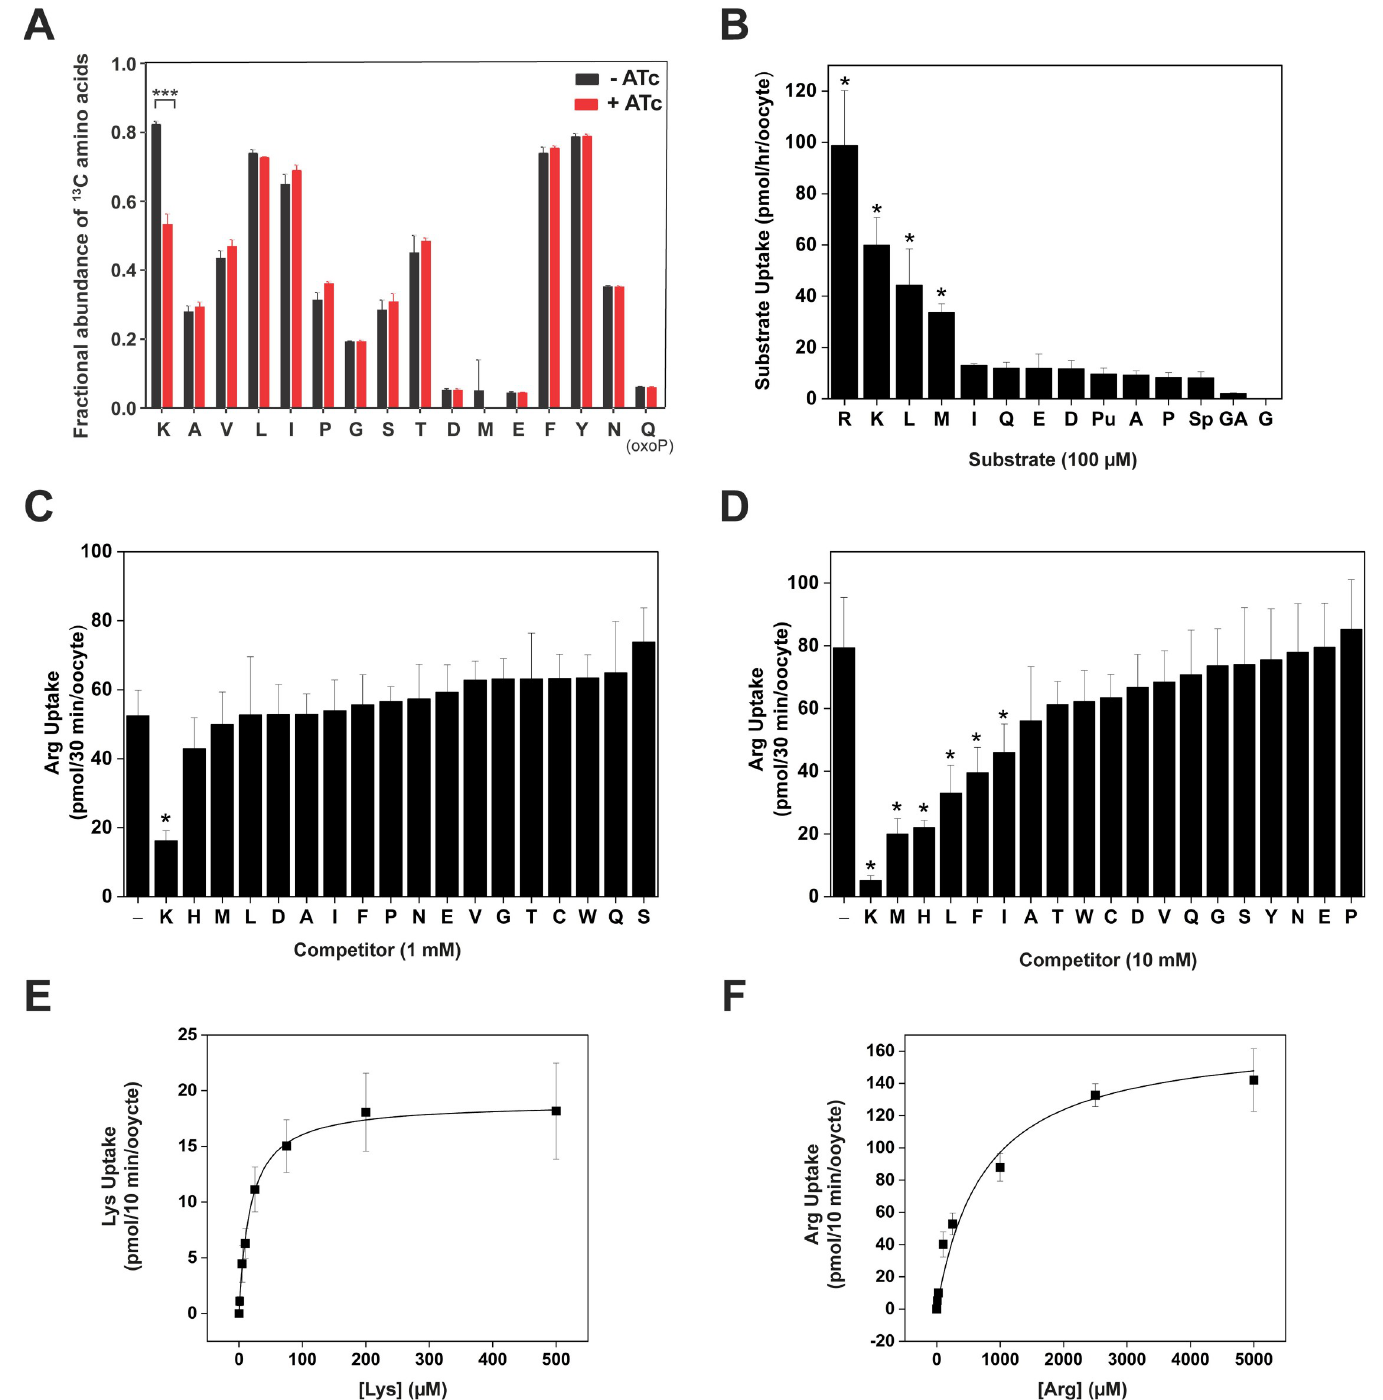
Fig 2. Tg ApiAT6-1is a cationic and neutral amino acid transporter with high affinity for Lysine. A .Analysis of [ 13 C] amino acid uptake in parasites expressing or lacking Tg ApiAT6-1. r Tg ApiAT6-1parasites were cultured for 2 days in the absence (black) or presence(red) of ATc until naturalegress, then incubated in medium containing[ 13 C]-L- amino acids for 15 min. Metabolites were extracted and the fractionsof [ 13 C]-L-aminoacids determined by GC-MS. Amino acids are representedby single letter codes; OxoP,5- oxoproline.The datarepresentthe mean ± S.D of 3 replicateexperiments ( � , P < 0.001, Student’s t test. Where significance values are not shown, differenceswere not significant; P > 0.05). B .Uptakeof a range of aminoacids into oocytesexpressing Tg ApiAT6-1. Uptakewas measured in the presenceof 100 μ Munlabelledsubstrateand 1.0 μ Ci/ml[ 3 H] or [ 14 C] substrate. Amino acid substratesare represented by single letter codes, while for other metabolites: Pu, putrescine; Sp, spermidine; and GA, γ -amino butyric acid (GABA). Each bar representsthe mean ± S.D. uptake of 10 oocytesfor a single experiment, and each is representative of three independent experiments. The